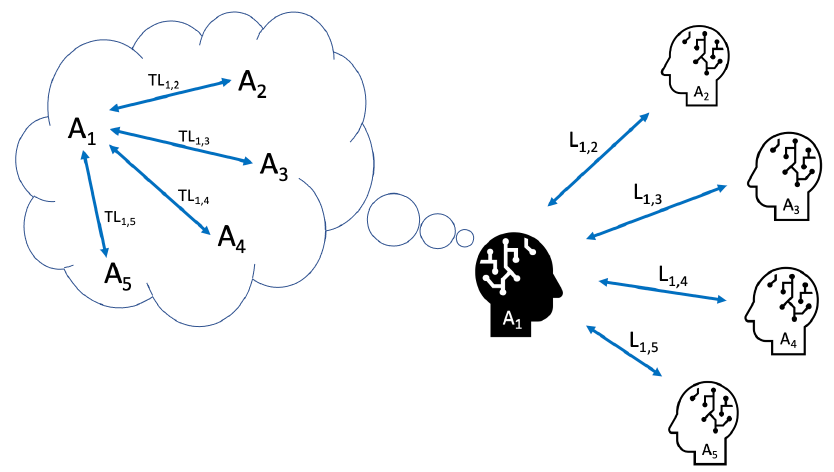
Figure 5. Real social networks and the cognitive representation needed for an agent to successfully navigate the social